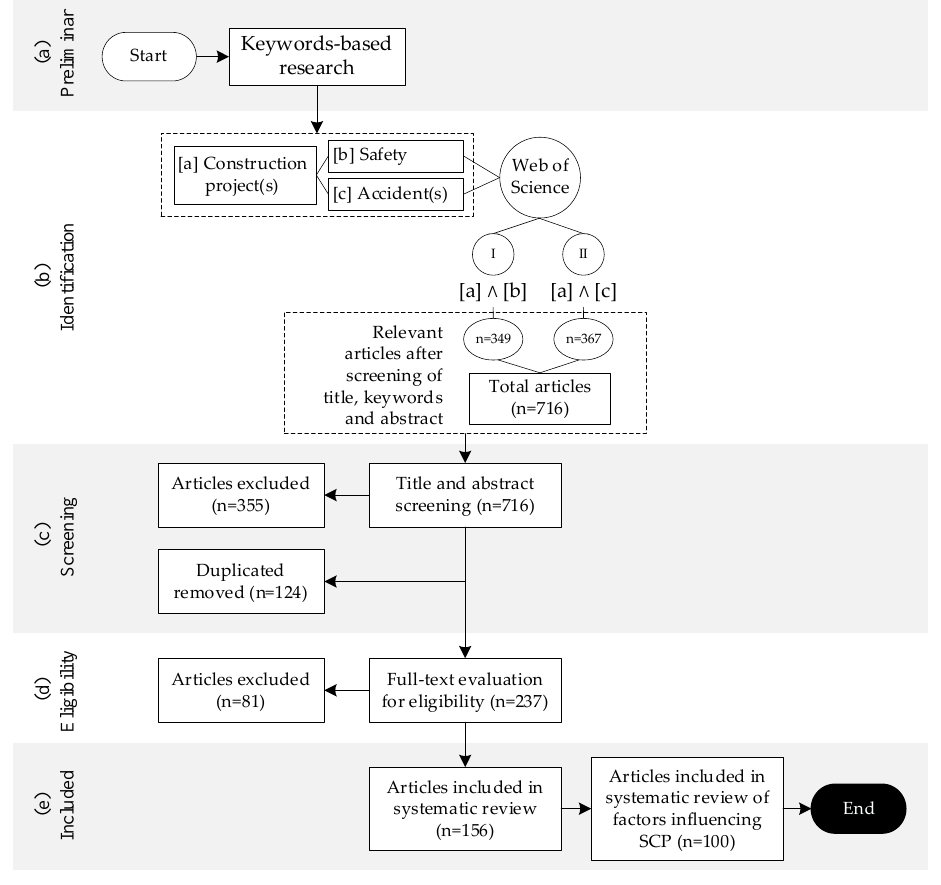
Figure 2. The PRISMA flow diagram for this systematic literature review.